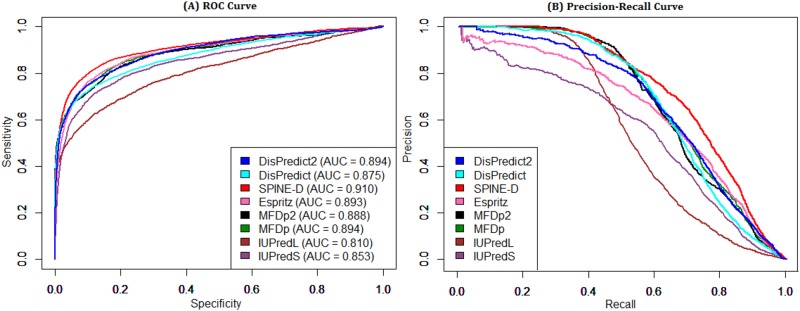
ROC and precision-recall curves given by 8 disorder predictors for CASP8 dataset.Comparison of disorder predictors in terms of (A) ROC curve and (B) precision-recall curve on CASP8 dataset. The area under ROC curves are given in the plot (A).